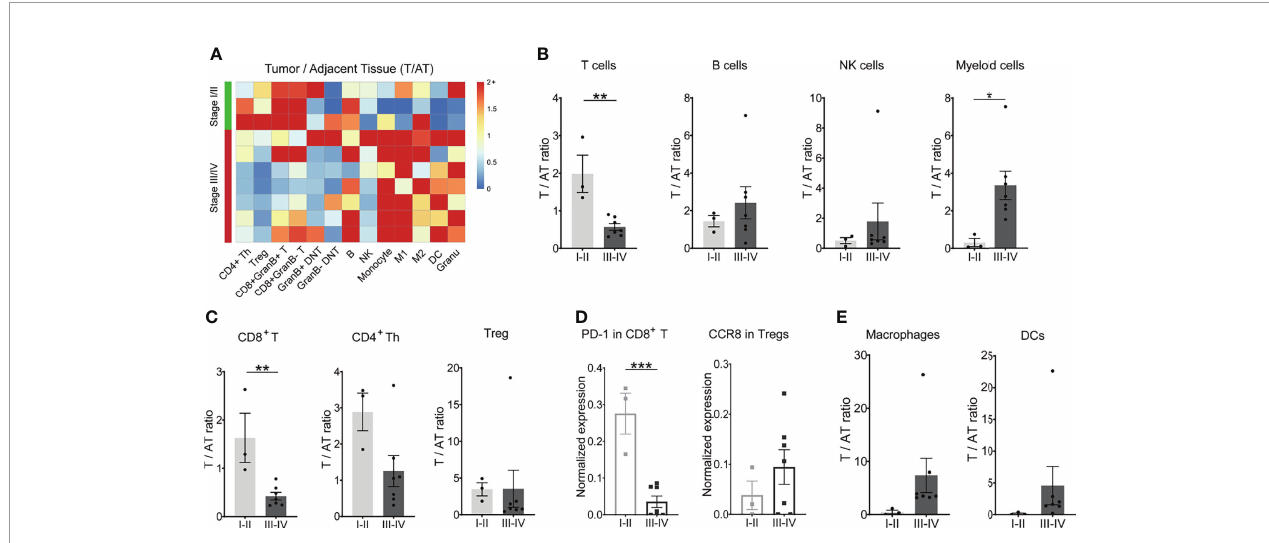
FIGURE 4 | Dynamic signature of the immune landscape underlying GC tumor progression. (A) Heatmap showing the relative differences in main immune cell lineages between tumor tissues and adjacent tissues across 10 patients, grouped by stage. Ratio ≥ 2 was shown as 2+. (B) Ratio of T, B, NK, and myeloid cells between tumor tissues and adjacent tissues (T/AT) for each patient by stage. (C) Ratio of CD8 + T cells, CD4 + Th cells, and Treg cells between tumor tissues and adjacent tissues (T/AT) for each patient by stage. (D) Expression level of PD-1 in CD8 + T cells and CCR8 in Tregs for tumor tissue of each patient by stage. (E) Ratio of macrophages and DCs between tumor tissues and adjacent tissues (T/AT) for each patient by stage. Bar plots show mean ± SEM; ***p < 0.001 by paired t-test.